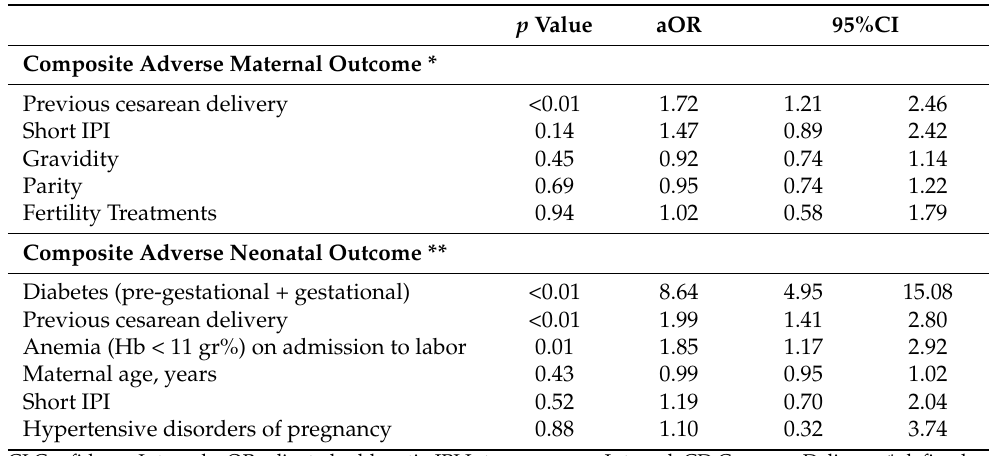
Table 5. Multivariate logistic regression analysis for the association between short IPI and composite adverse maternal and neonatal outcomes (Adjusted Odds